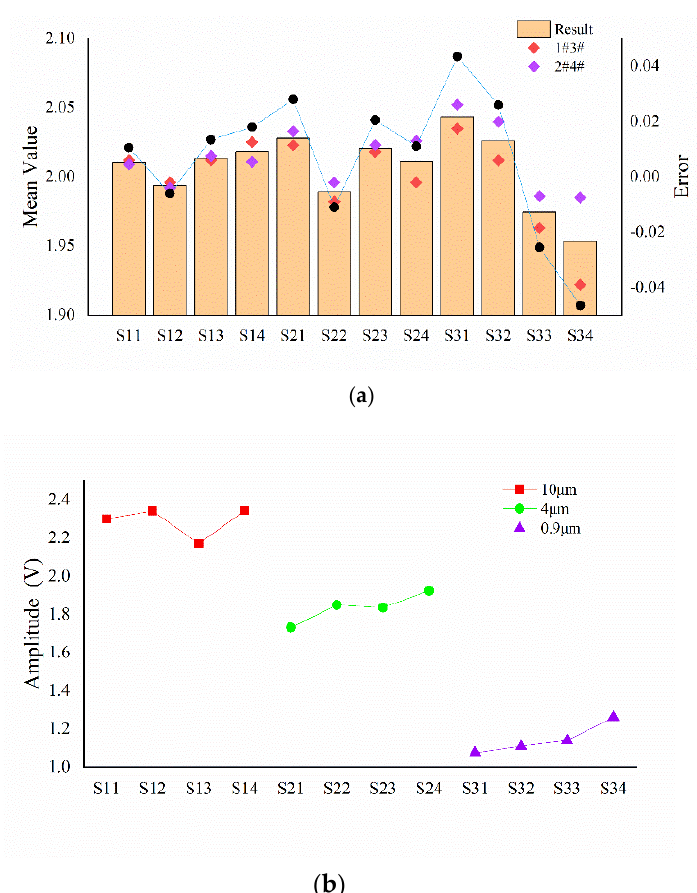
Figure 9. Experimental result of texture detection: ( a ) the result of spatial period estimation; ( b ) the result of ridge height recognition.